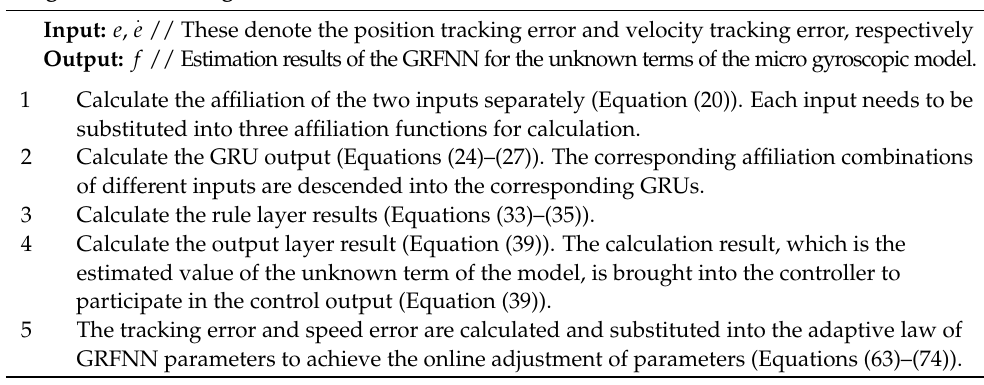
Algorithm 1: The algorithm of the